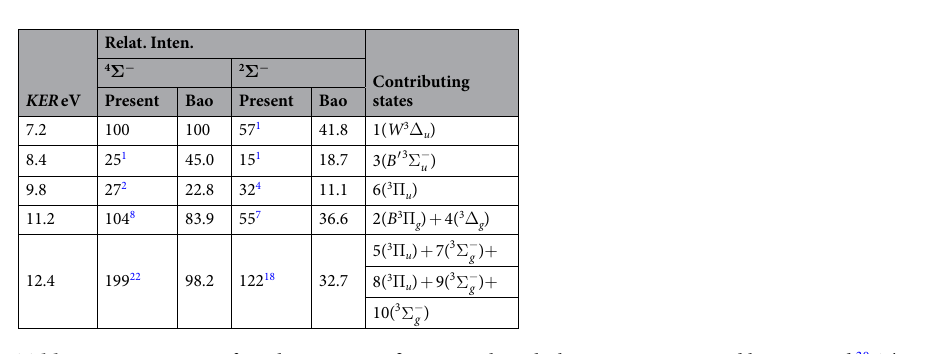
Contributing states